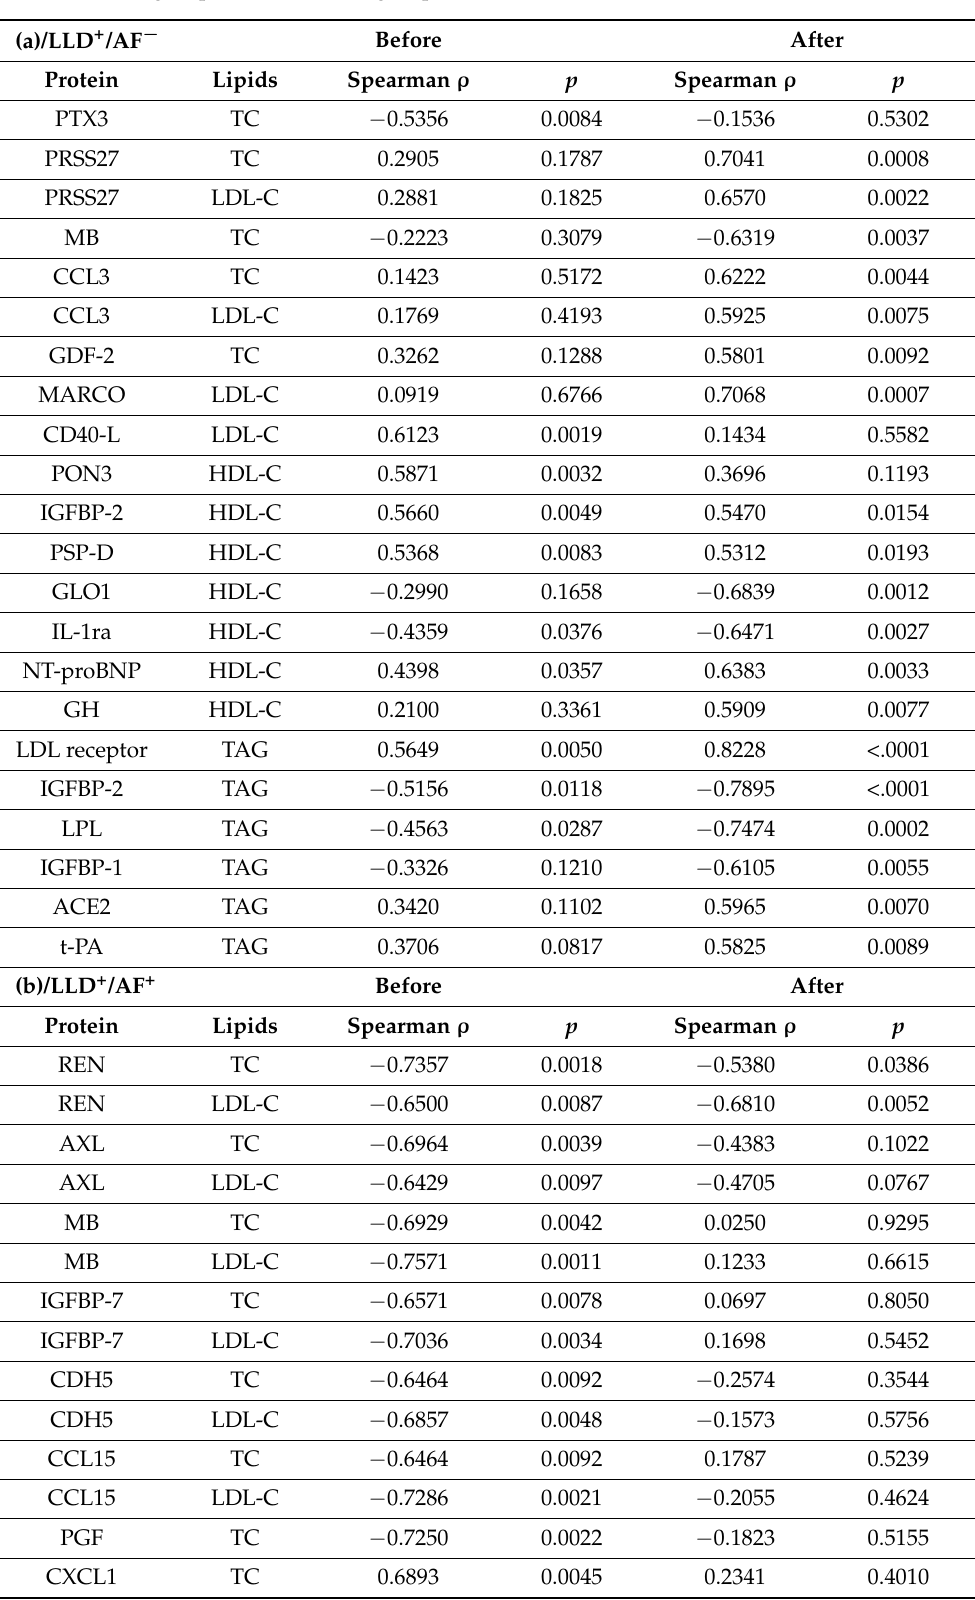
Table 2. Nonparametric Spearman’s correlation of overall plasma lipids and protein